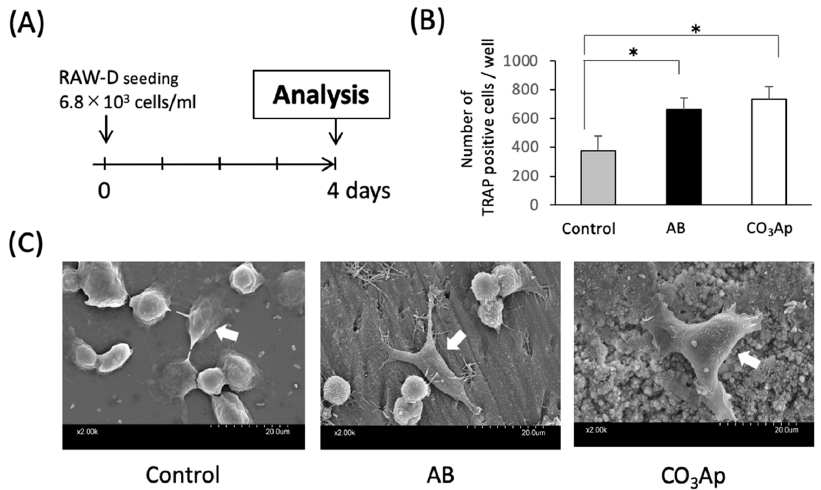
Figure 1. Evaluation of osteoclast activity in an in vitro study. ( A ) Experimental protocol of the in vitro study. ( B ) The number of TRAP positive cells ( n = 5, * p < 0.05). ( C ) The shape of the osteoclast-like cells (white arrows) (control: culture dish, AB: dentin piece, CO 3 Ap: Cytrans disc).